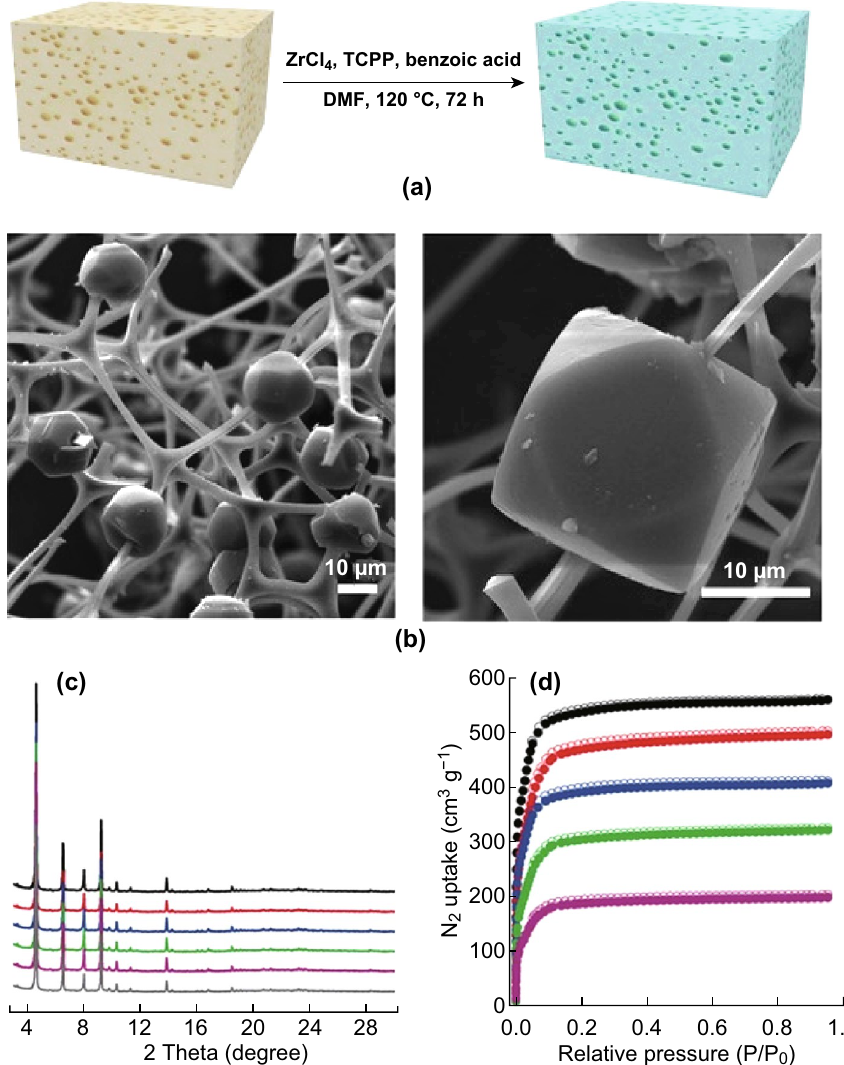
Fig. 7 a Procedure for the preparation of PCN-224 decorated melamine foam composites. b FESEM images of PCN-224(Fe)/MF composite depicting the melamine foam network homogeneously decorated with PCN-224(Fe) microcrystals. c The high similarities between the PXRD patterns of PCN-224(Fe) (grey), PCN-224(Fe) 50% /MF (purple), PCN-224(Fe) 100% /MF (green), PCN-224(Fe) 150% /MF (blue), PCN-224(Fe) 200% / MF (red), and PCN-224(Fe) 325% /MF (black) indicating the structural stability of the MOF composites. d N 2 sorption isotherms of PCN- 224(Fe) 50% /MF (purple), PCN-224(Fe) 100% /MF (green), PCN-224(Fe) 150% /MF (blue), PCN-224(Fe) 200% /MF (red), and PCN-224(Fe) 325% /MF (black). The BET surface areas increased with the increasing loading amount of PCN-224(Fe) in the composites. Reprinted with permission from Ref. [78]. Copyright 2018 Wiley-VCH Verlag GmbH & Co. KGaA, Weinheim. (Color figure